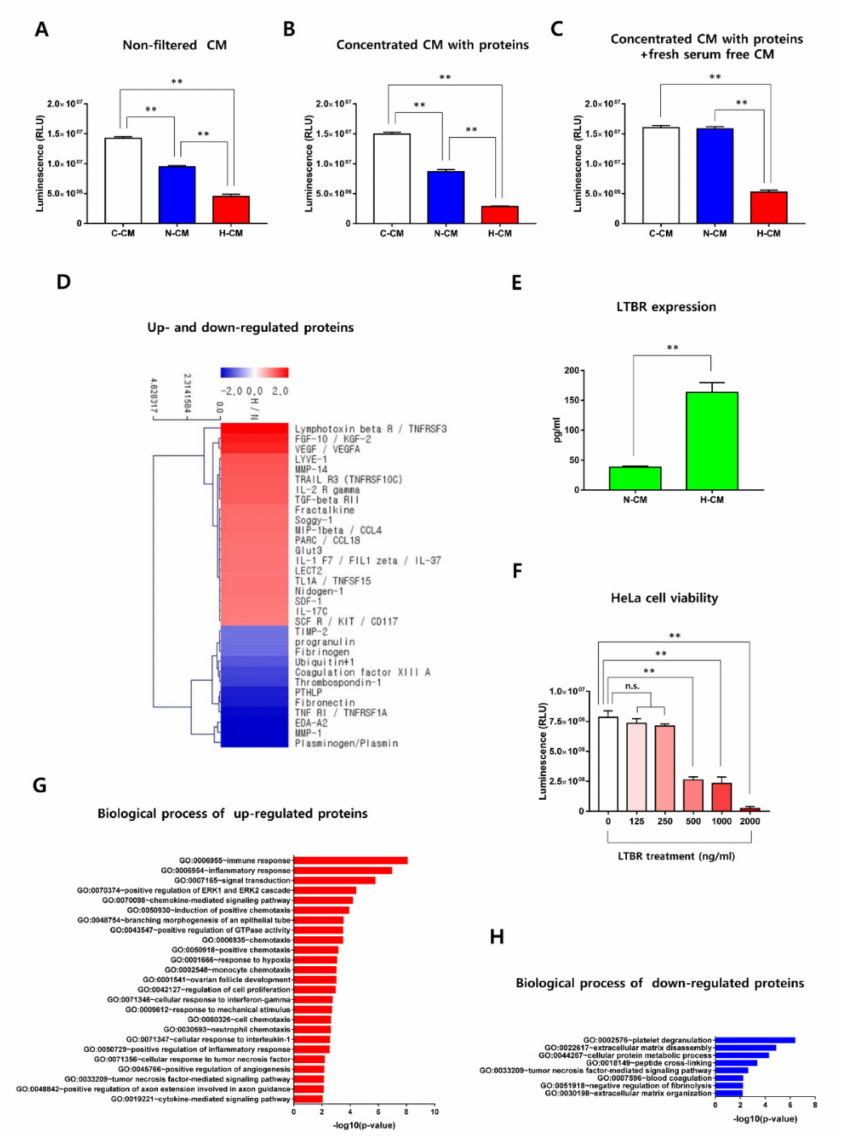
Figure 3. Proteins in H-CM decreased the viability of HeLa cells. The viability of HeLa cells treated with non-filtered C-CM, N-CM, or H-CM ( A ). The viability of HeLa cells treated with concentrated C-CM, N-CM, or H-CM with proteins ( B ). The viability of HeLa cells treated with concentrated C-CM, N-CM, or H-CM with proteins in fresh serum-free medium ( C ). The viability of HeLa cells was measured using the CellTiter-Glo assay after 72 h of treatment with the given CM. Data are